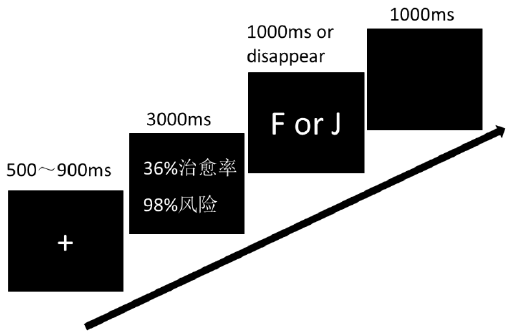
Figure 2. Flow chart of experiment. 治愈率 in English: cure rate; 风险 in English: Figure 2. flow chart of experiment. 治愈率 in English: cure rate; 风险 in English: Risk.